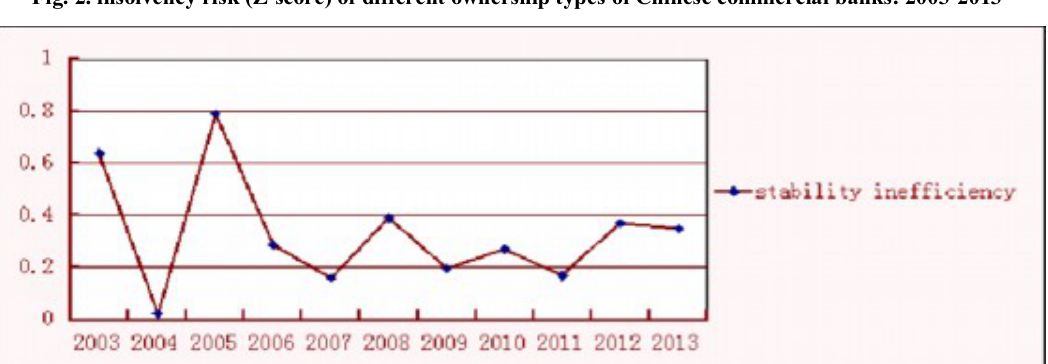
Fig. 2. insolvency risk (Z-score) of different ownership types of Chinese commercial banks: 2003-2013